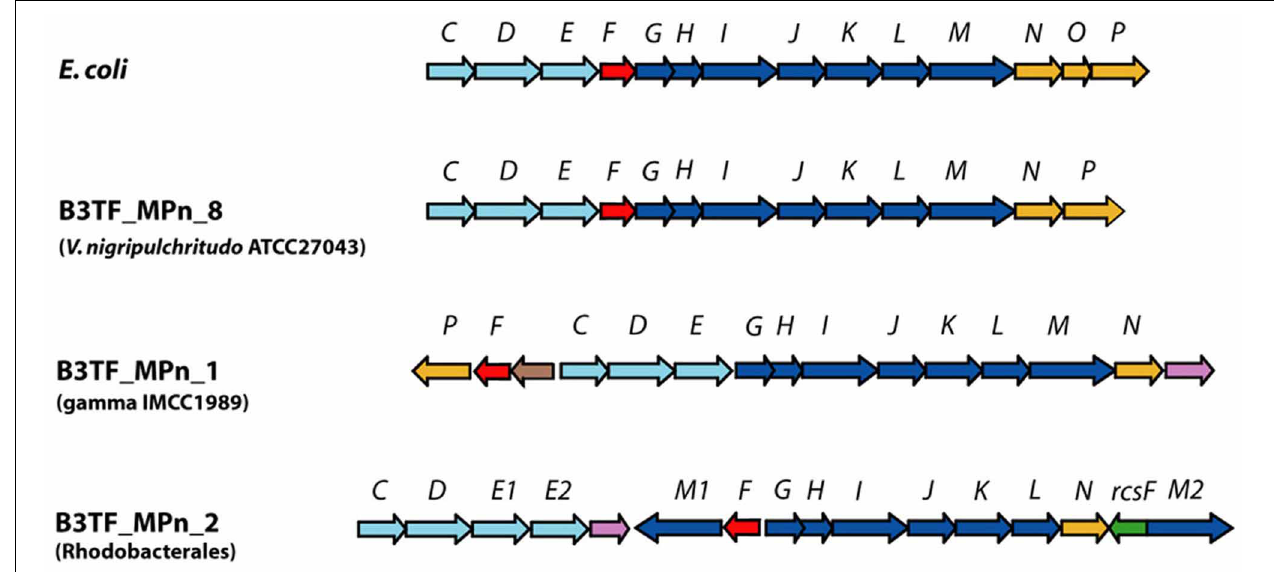
FIGURE 8 | Schematic representation of C-P lyase gene clusters in E. coli and environmental fosmids identified in the MPn utilization functional screen of the B3_TF library. Genes are marked according to their assigned function as follows: putative ABC transporter components (light blue),